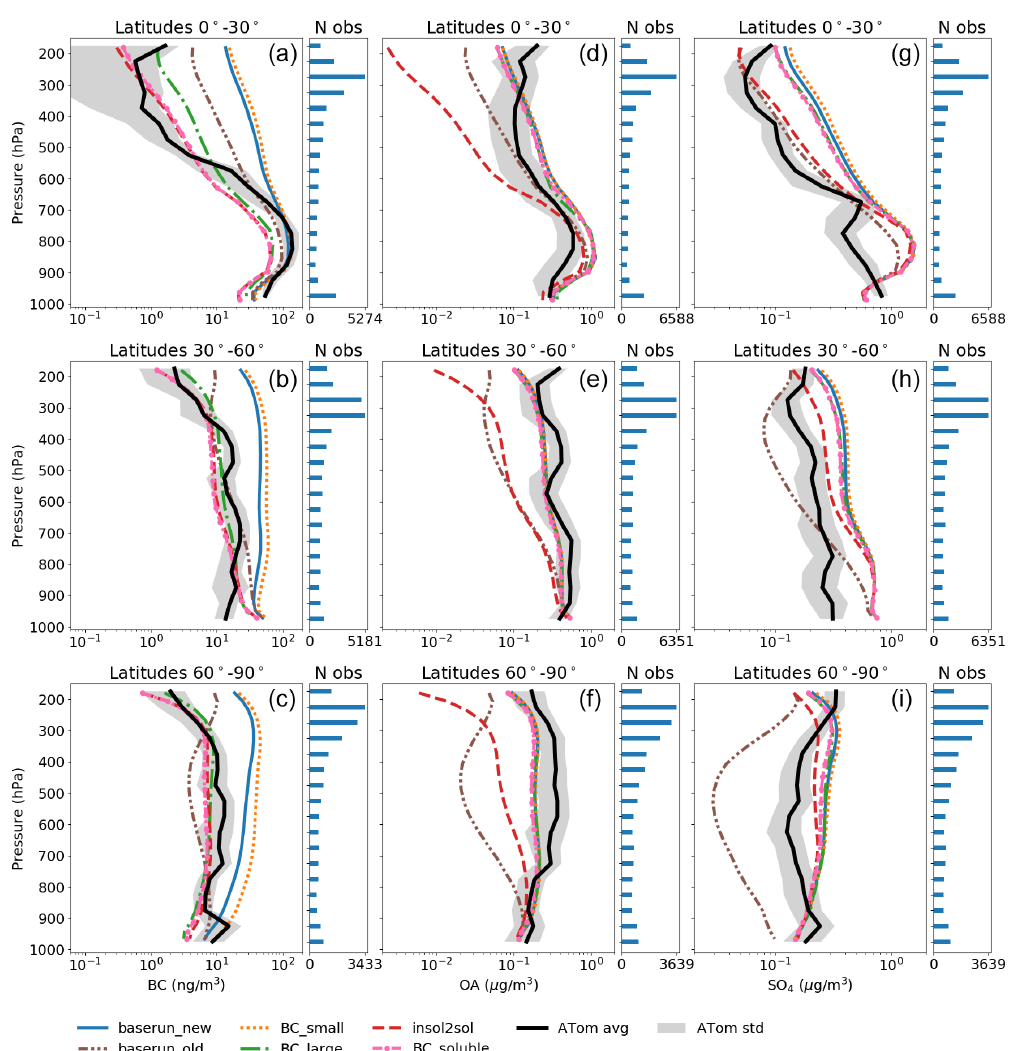
Figure 5. Mean vertical profiles of BC (a–c) , OA (d–f) , and SO 4 (g–i) , modeled with different studies, compared to the mean of ATom aircraft measurements at different latitude bands. To the right of every panel is the number of observations measured by the device, at each vertical level, from the ATom aircraft measurement campaigns. Note the different units for the different